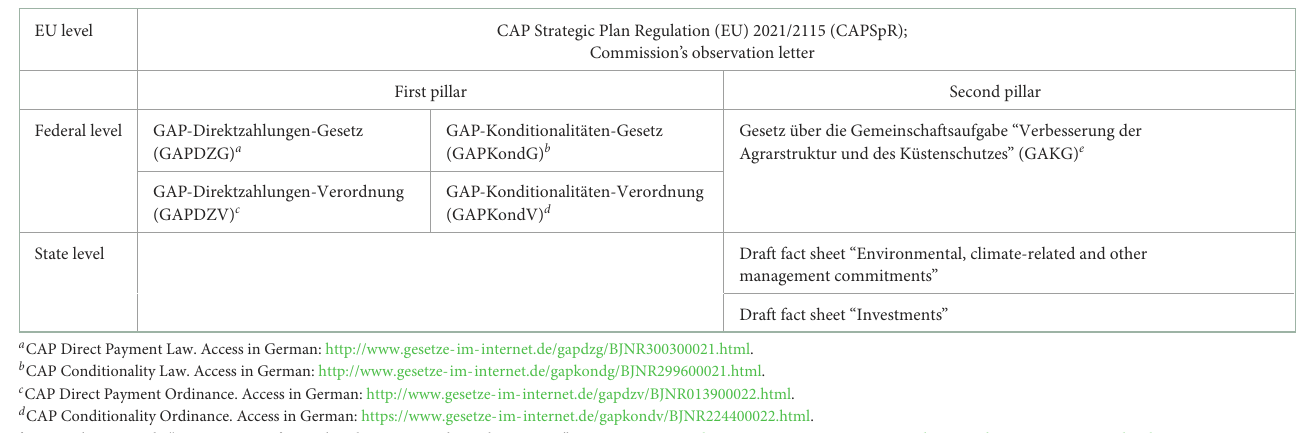
TABLE 1 Overview of legal